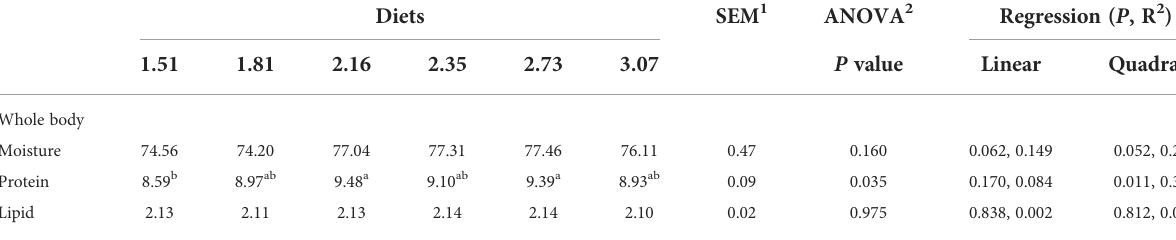
TABLE 6 Whole-Body composition in postlarval Scylla paramamosain fed with diets containing different arginine levels (in % of wet weight basis).